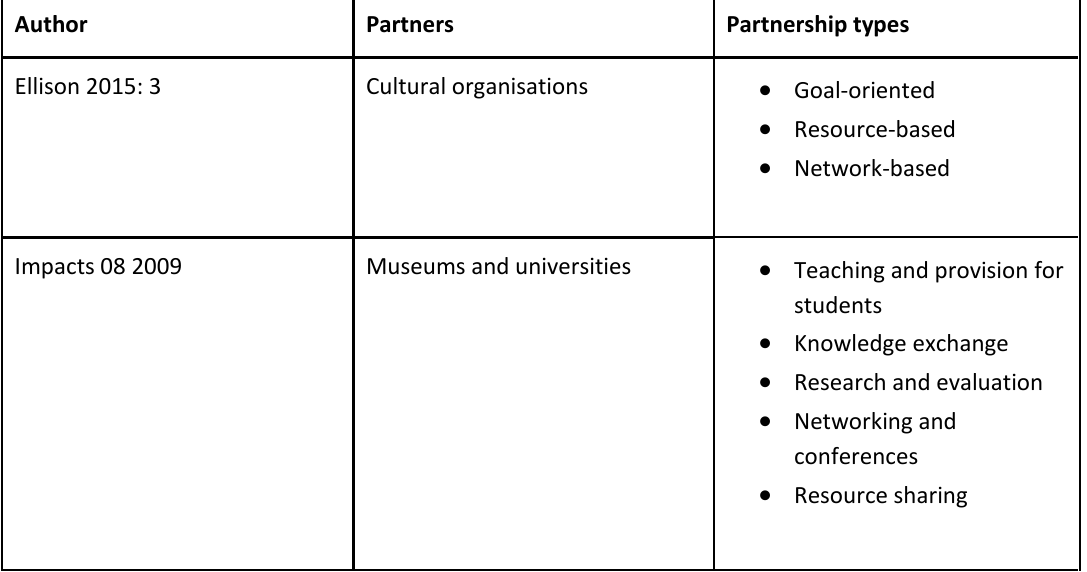
Table 1. Types of partnerships identified in